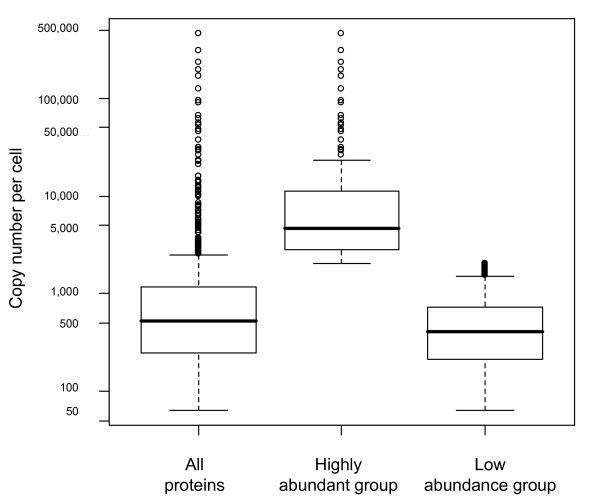
Abundance distribution of all identified proteins. Distributions are shown for the group of highly abundant proteins and the remaining low abundance protein group. Circles show distribution outliers as defined in Methods. The lower hinge represents the first quartile (25%) and the upper hinge the third quartile (75%). The high and low group were separated by clustering at a copy number cutoff of 2050 proteins per cell as described in Methods.